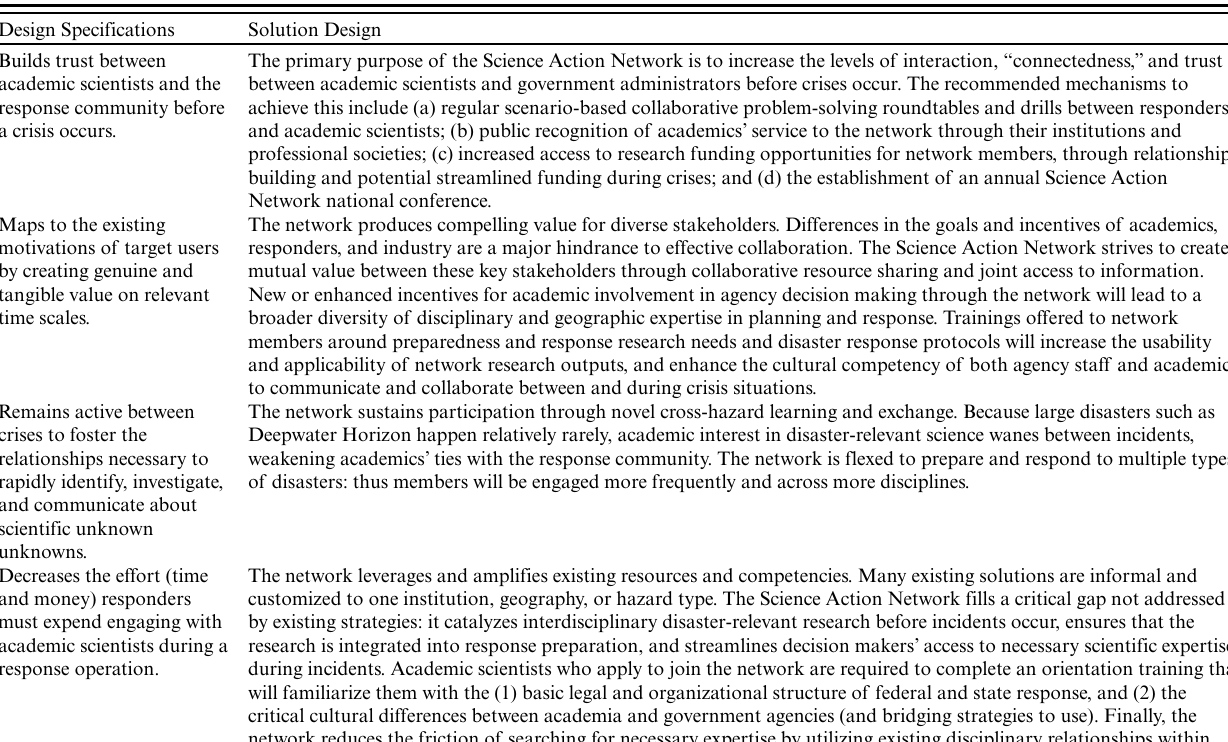
Table 3 . Design specifications distilled from ethnography and how the final proposed solution, the Science Action Network, met those